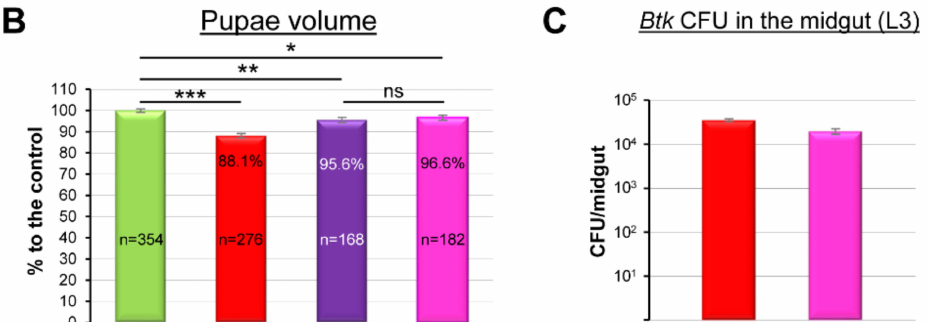
Figure 4. L. plantarum activity helps to overcome Btk bioinsecticide impacts ( A ) Pupation curve of larvae reared on a medium complemented with 10 6 CFU of L. plantarum and contaminated with Delfin 10X (pink) or not (purple) compared to control larvae (green) or Delfin 10X only (red). 144 < n < 214. ( B ) Pupae volume derived from larvae raised on a medium complemented with 10 6 CFU of L plantarum and contaminated with Delfin 10X (pink) or not (purple) compared to control pupae reared on control medium (green) or medium contaminated with Delfin 10X only (red). ( C ) Btk load in the midgut of L3 reared on a medium contaminated with Delfin 10X and complemented (pink) or not (red) with 10 6 CFU of L. plantarum . Errors bars represent the SEM. ns means not significative, * p < 0.05, ** p < 0.01, *** p < 0.001 compared with